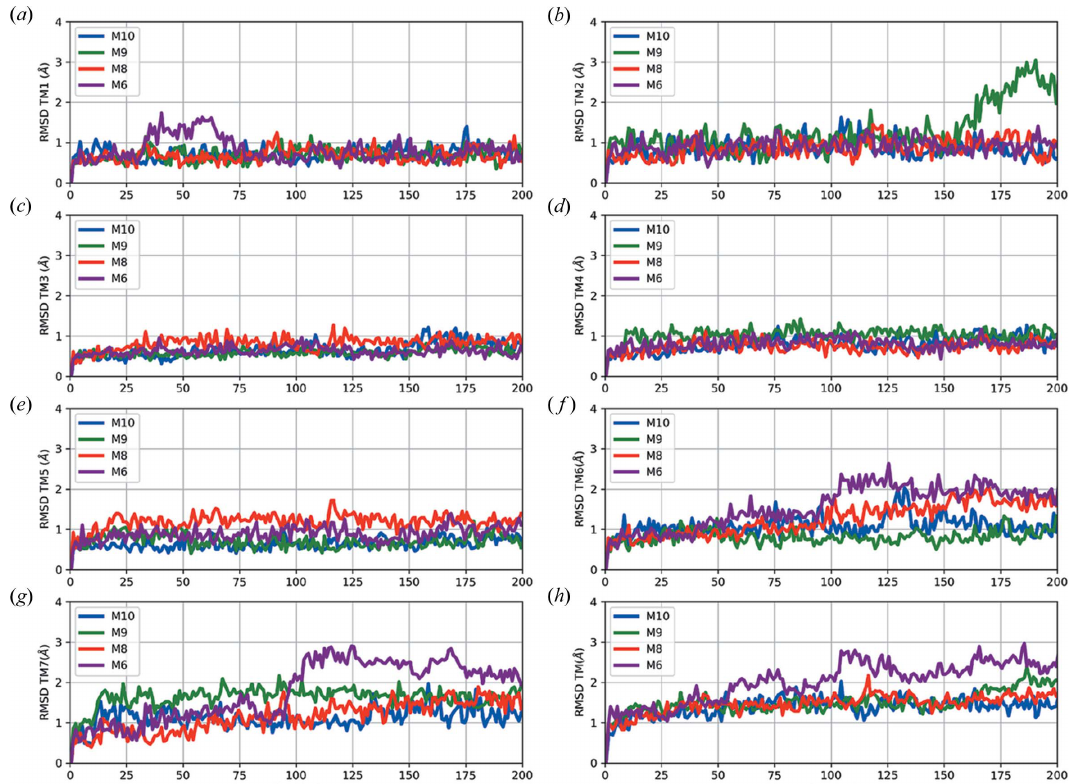
Figure 3 MD simulation results of the four crystallized constructs. ( a )–( g ) The RMSD of TMs 1–7 individually and ( h ) the RMSD of overall TMD. The RMSD was computed with respect to the equilibrated